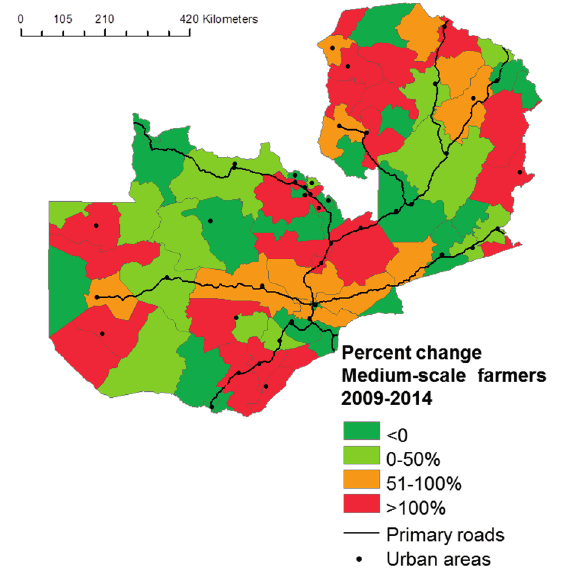
Figure 2. Percent change in number of medium-scale farms relative to the total small and medium-scale population 2009–2014. Source: computed from CFS 2009 and 2014.